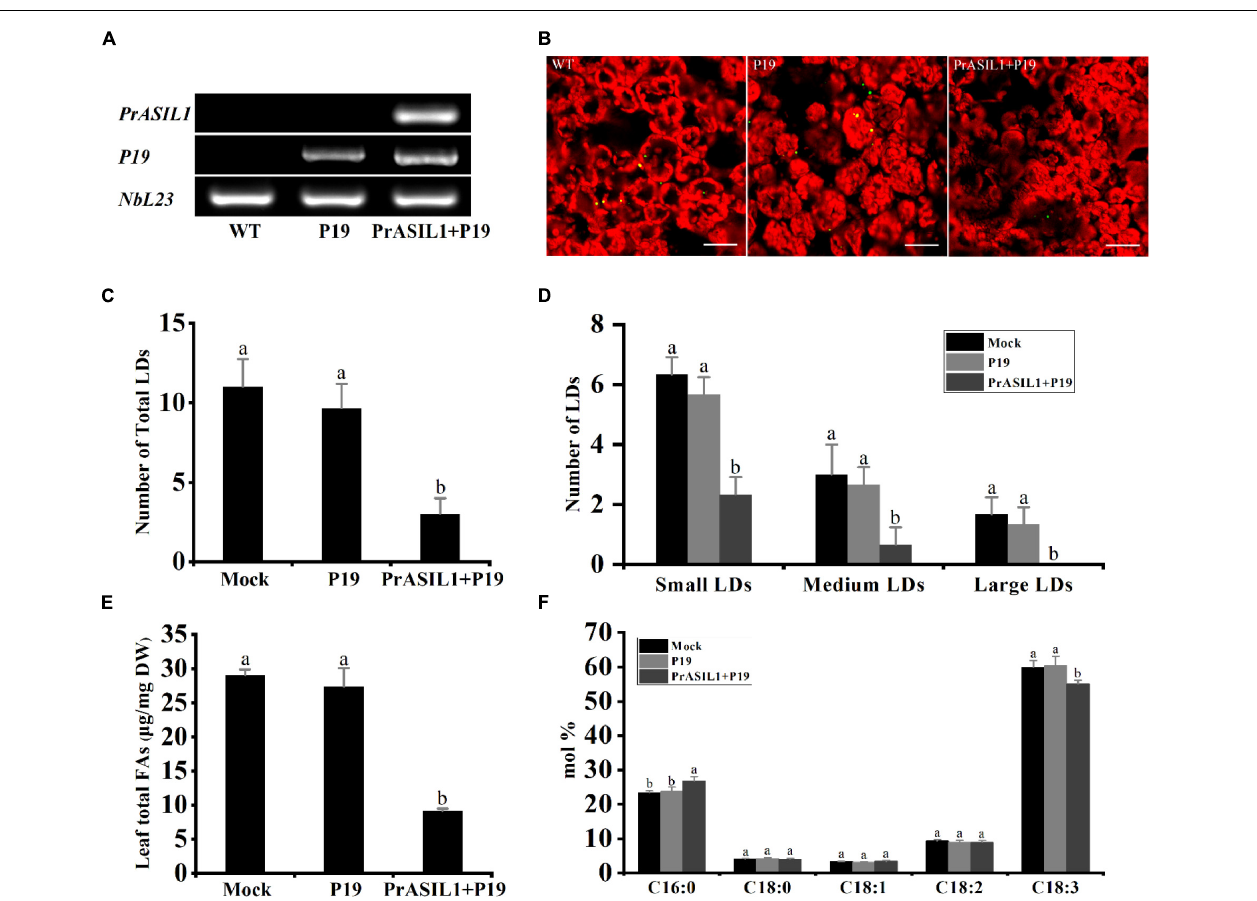
FIGURE 3 | PrASIL1 reduces oil content and changes FA profiles in transformed N. benthamiana leaf tissue. (A) RT-PCR analysis of PrASIL1 expressed in tobacco leaf tissue. (B) Representative confocal images of LDs in N. benthamiana leaf tissue. Green color shows LDs and red color shows chloroplast. Images are shown a 232.50 × 232.50 µ m 2 field of the leaf tissue. Bars = 40 µ m. (C) Number of total LDs per image area in PrASIL1- transformed, mock, and P19-transformed N. benthamiana leaf tissue. (D) Number of LDs in different size categories per image area. Small LDs: Nile Red-stained lipid area < 3 µ m 2 , Medium LDs: 3–6 µ m 2 , Large LDs: 6–10 µ m 2 . (E) Comparison of total FA content ( µ g/mg) among PrASIL1- transformed, mock, and P19-transformed N. benthamiana leaf tissue. (F) Fatty acid composition of PrASIL1- transformed, mock, and P19-transformed N. benthamiana leaf tissue. DW, Dry weight. Values are mean ± SD ( n = 3). Different letters indicate significant difference at P < 0.05, as confirmed by one-way ANOVA with Tukey’s